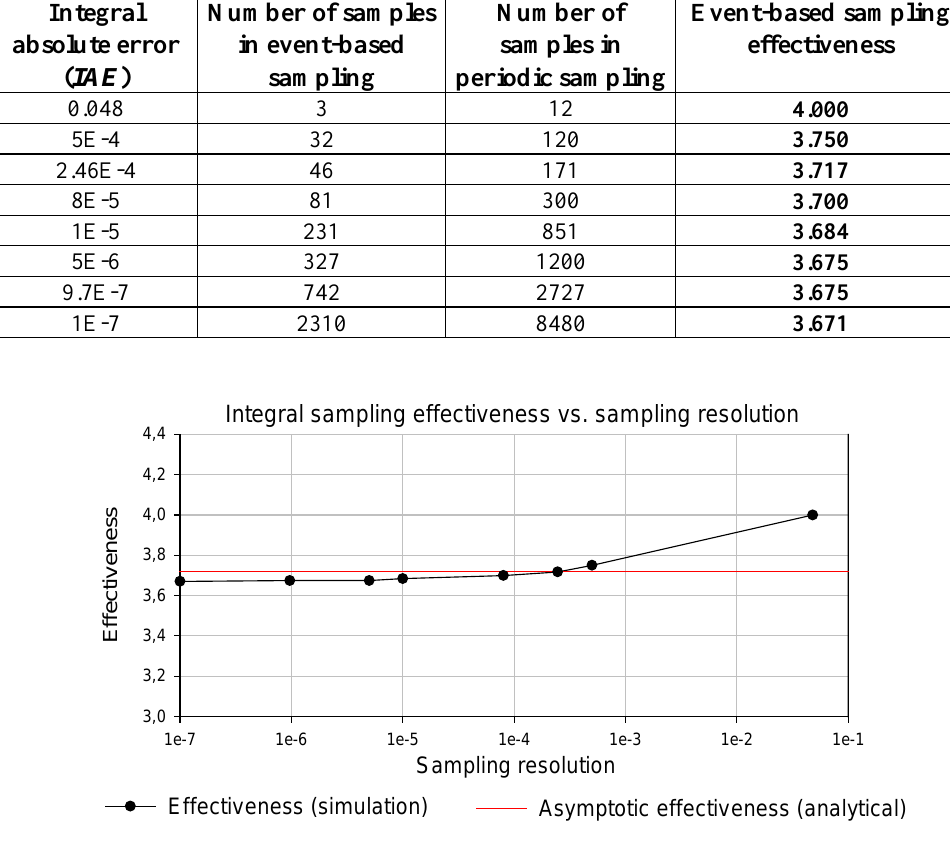
Figure 7. Simulation results versus analytical approximation for the integral sampling asymptotic effectiveness. The approximation is accurate for small integral absolute error ( IAE